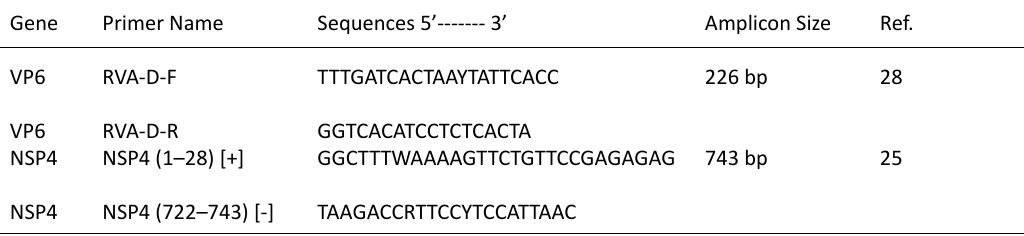
table 1. Primers used for the diagnosis and characterization of small ruminant origin RVAs using RT-PCR assay Gene